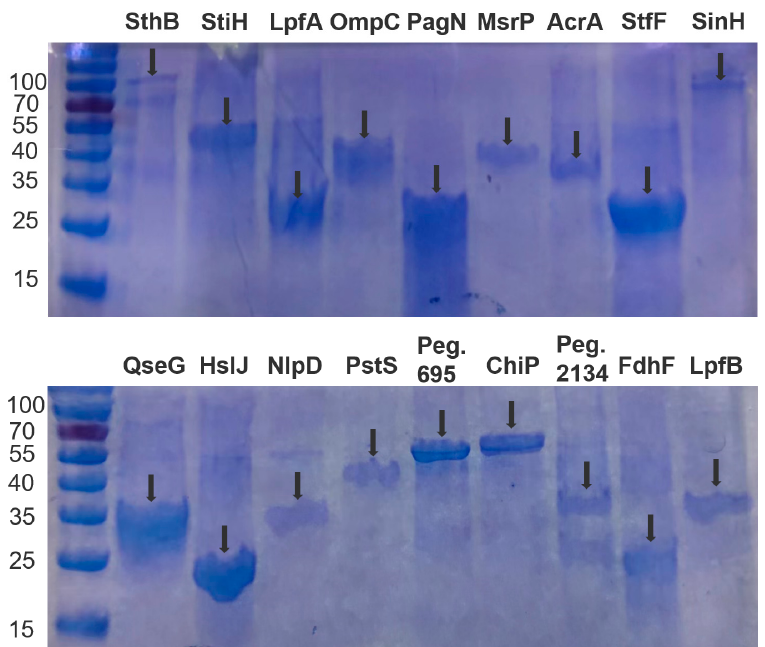
Figure 3. SDS-PAGE analysis of 18 recombinant target proteins expressed in E. coli Rose tt a after puri fi cation. The arrows indicate the protein band for further